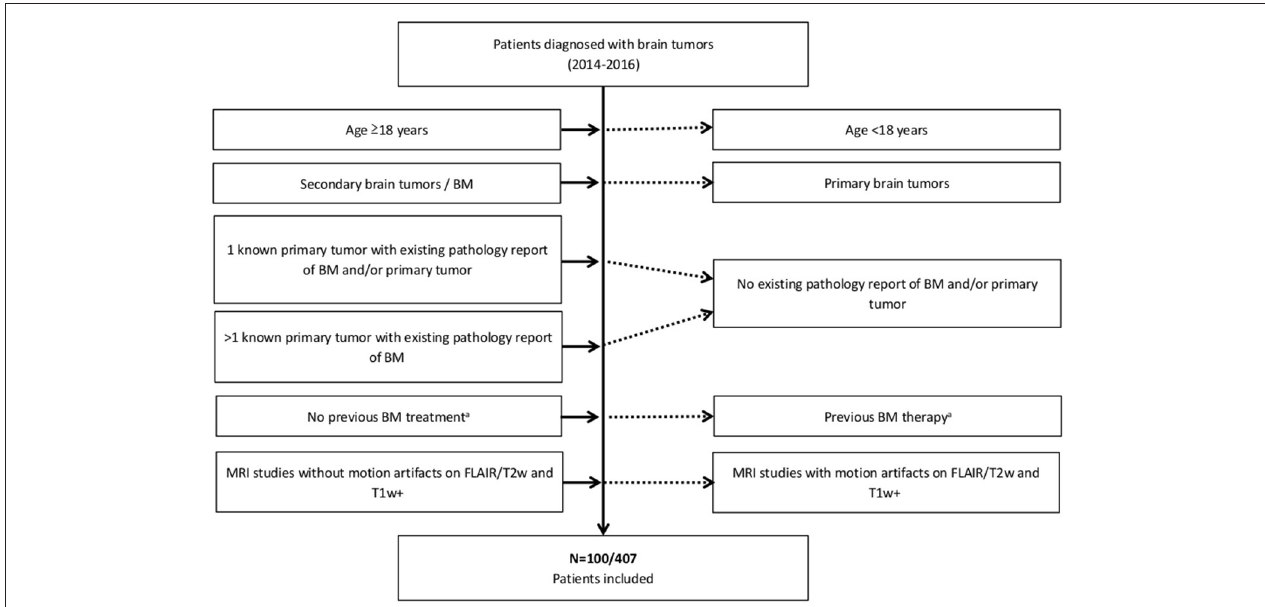
FIGURE 2 | Summary of the inclusion (Left) and exclusion criteria (Right) . a No surgery, radiotherapy, or chemotherapy (e.g., bevacizumab) for treatment of BM previous to MRI.